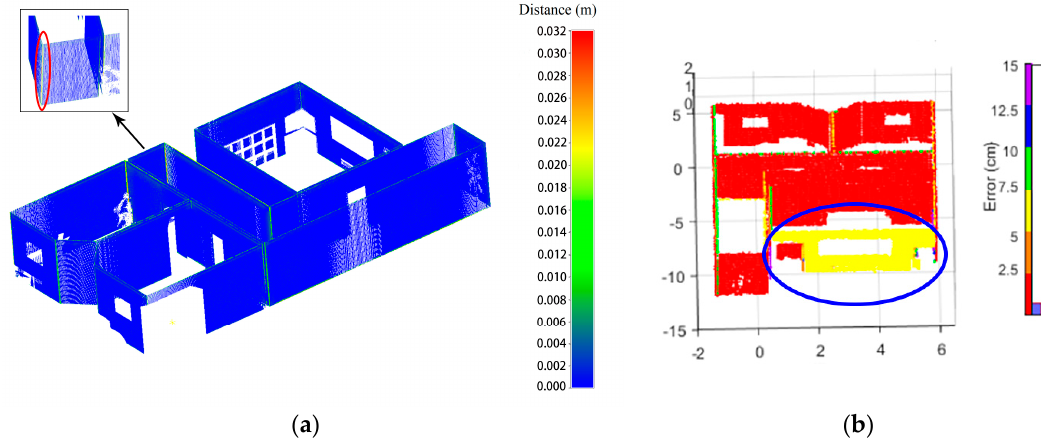
Figure 11. Comparison of the accuracy of the model generated from the synthetic dataset (a histogram of errors is shown at the right side): ( a ) accuracy of our model (the accuracy of the wall intersection part in the red circle is around 2 to 3 cm), ( b ) accuracy of Shi’s model (the accuracy of the wall part in the blue circle is around 5 to 7.5 cm).